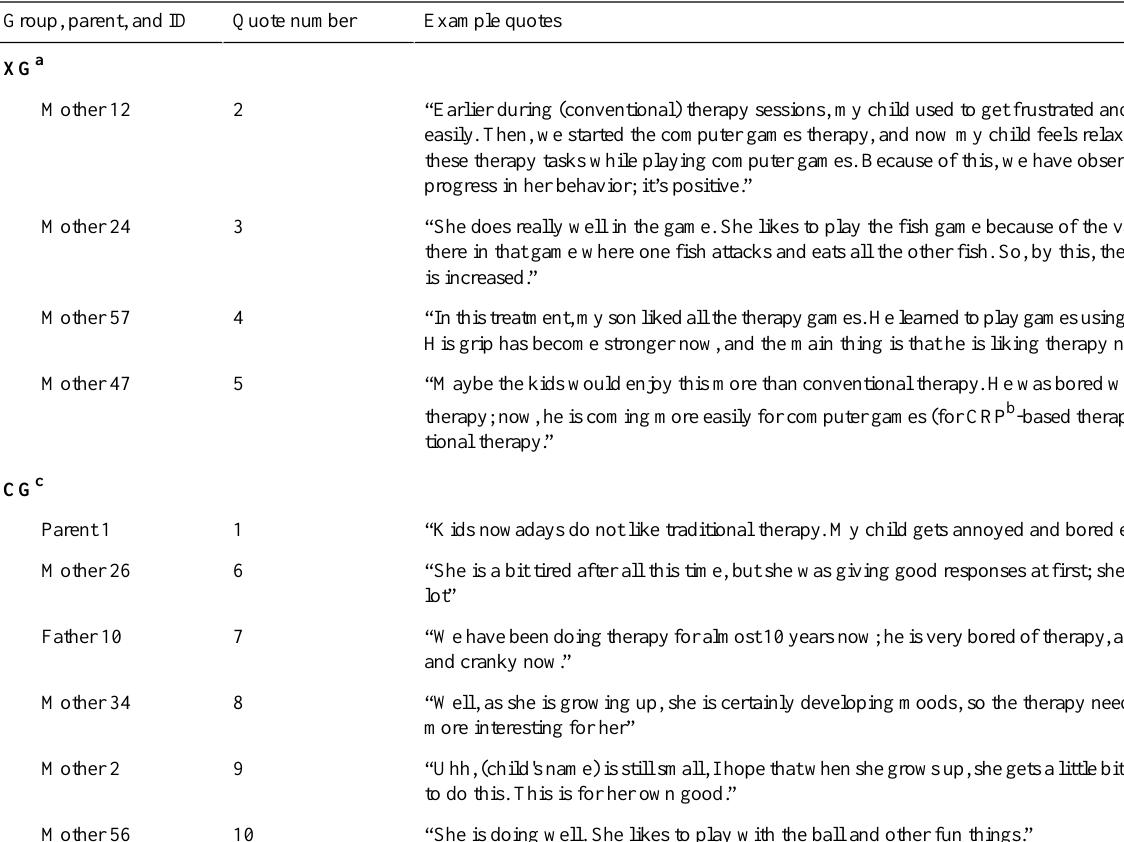
Table 4. Parents’responses about their child’s engagement with